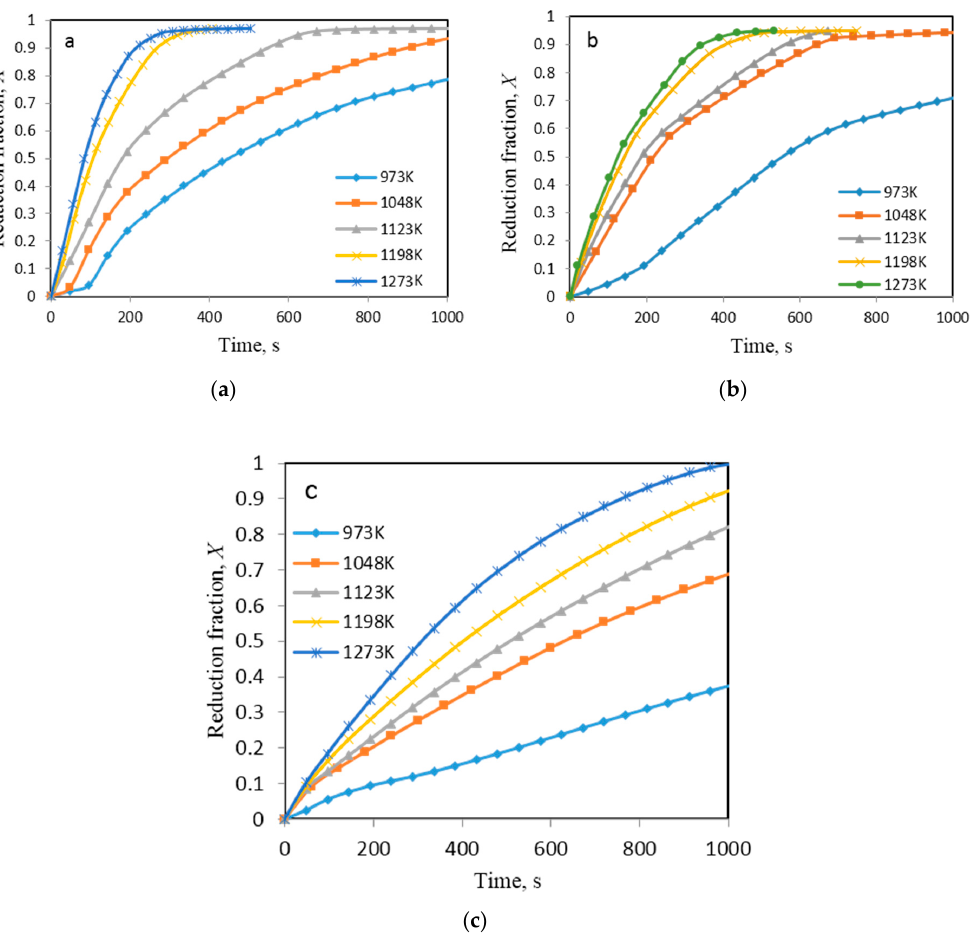
Figure 11. Experimental results for fractional reduction as a function of time. ( a ) Ni/(Ni + W) = 0.7; ( b ) Ni/(Ni + W) = 0.5; ( c ) Ni/(Ni + W) = 0.4 molar ratio [3].